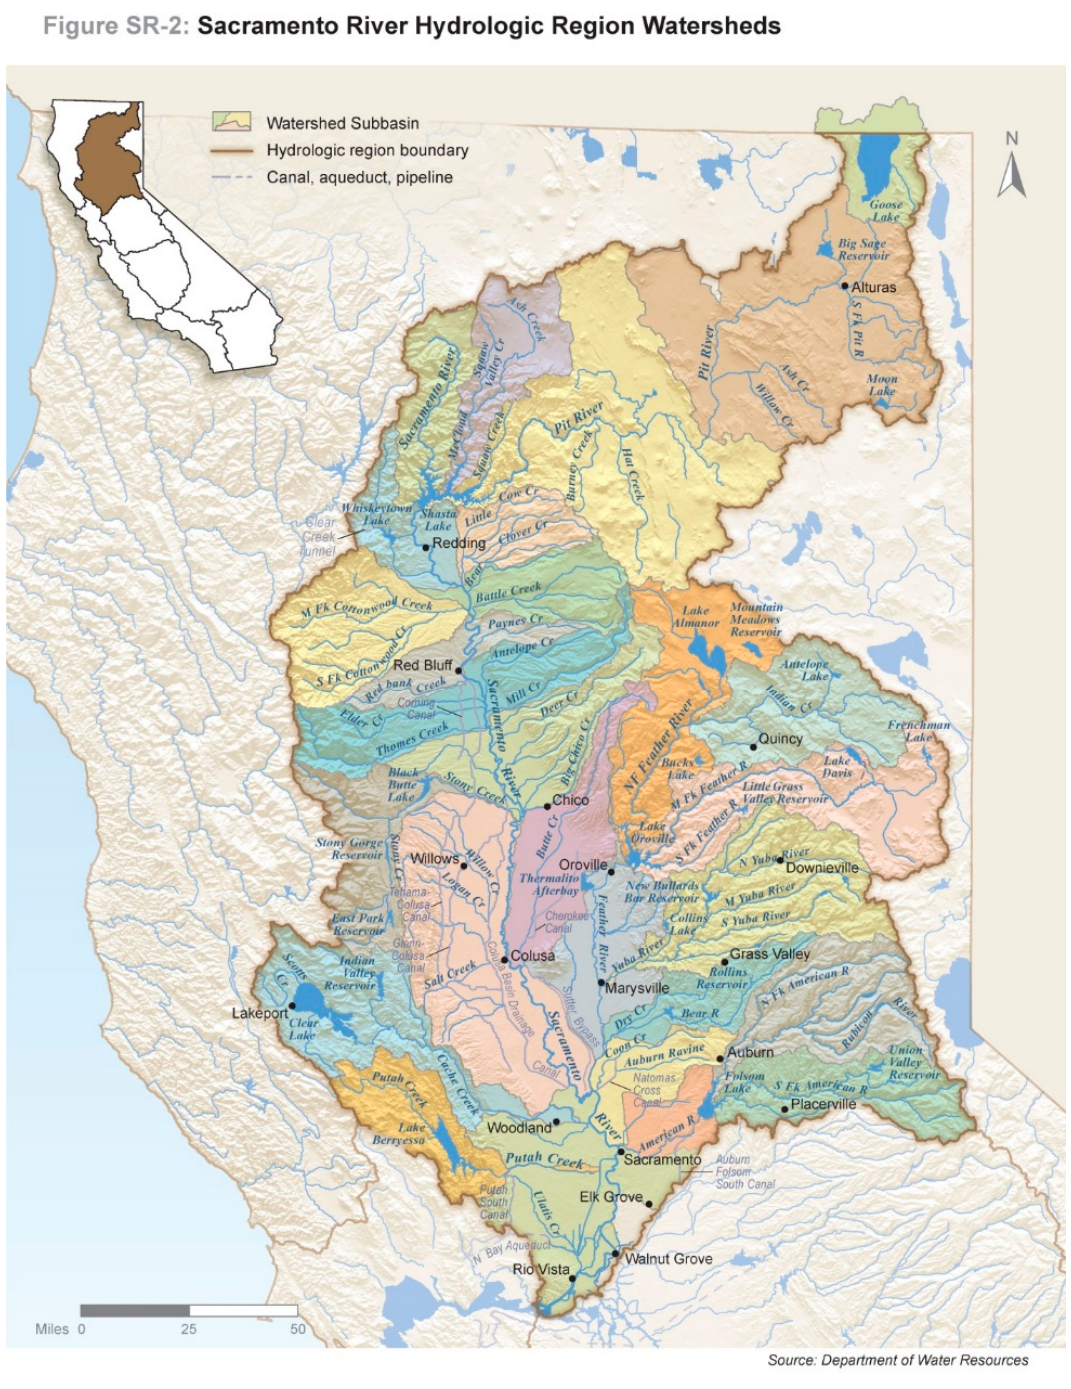
Figure 5. The Sacramento River watershed encompasses much of northern California, eventually flowing into the San Francisco Estuary (from the California Water Plan Update 2013 , California Department of Water Resources